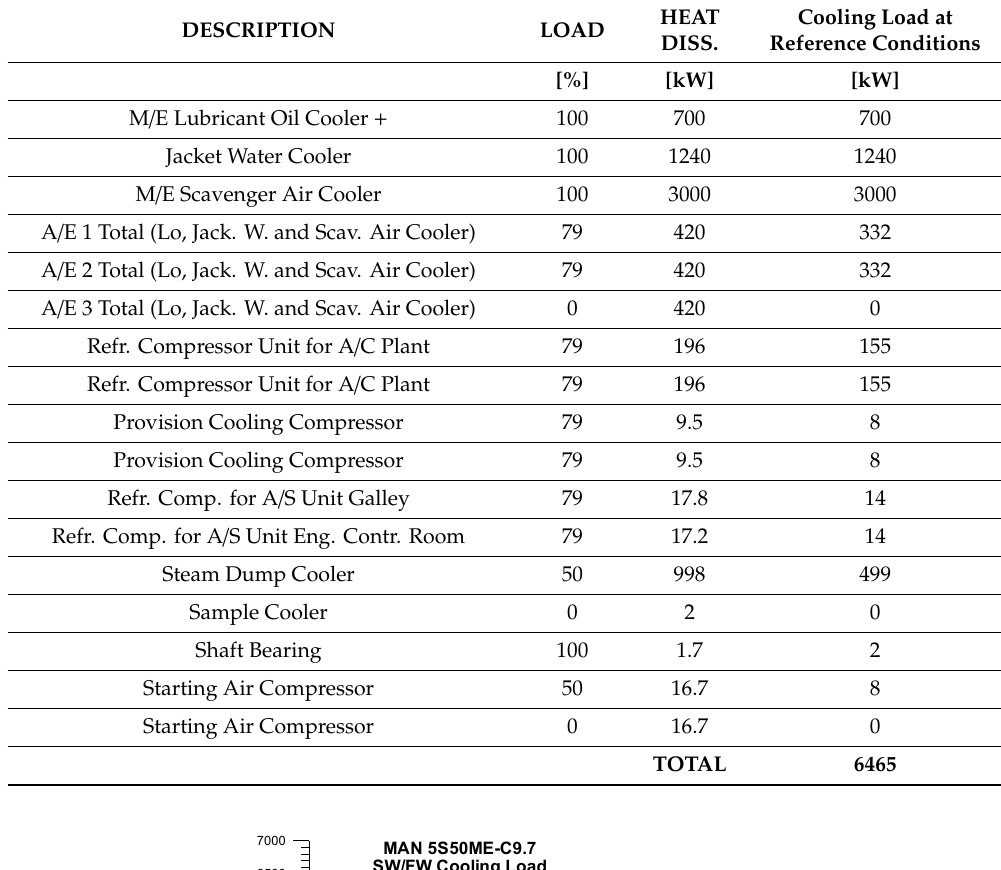
Table 5. Distribution of cooling demand at reference conditions [6].